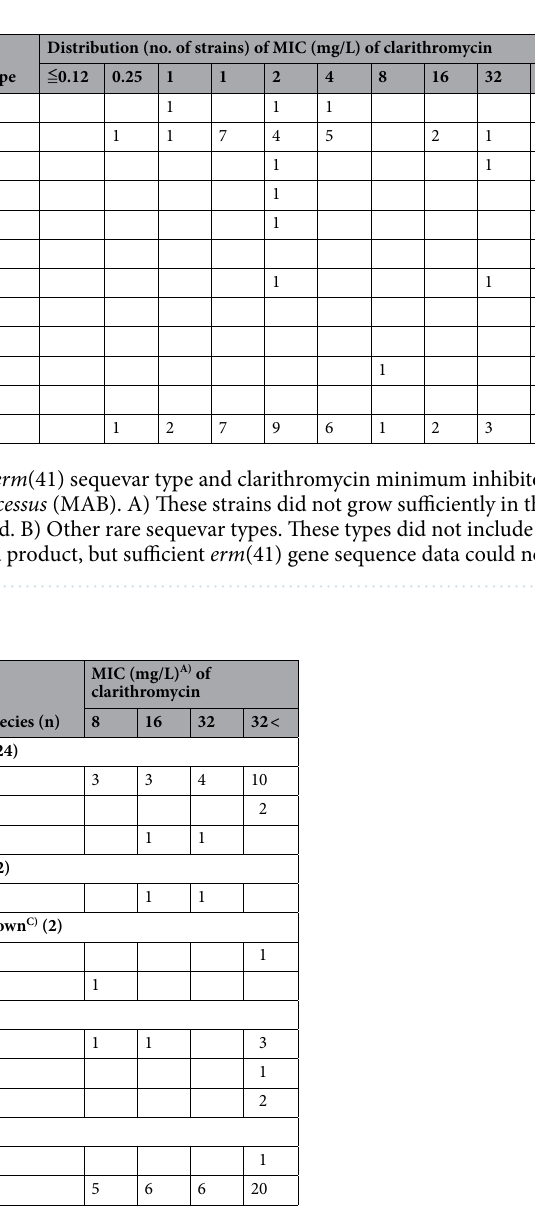
Table 6. Frequency of rrl mutation in 37 Mycobacteroides abscessus group (MAG) strains. A) Acquired resistance = CAM minimum inhibitory concentration (MIC) ≥ 8 mg/L at early-reading-time. B) PCR was performed to obtain a product, but sufficient rrl gene sequence data could not be obtained. C) PCR was performed to obtain a product, but sufficient erm (41) gene sequence data could not be obtained.